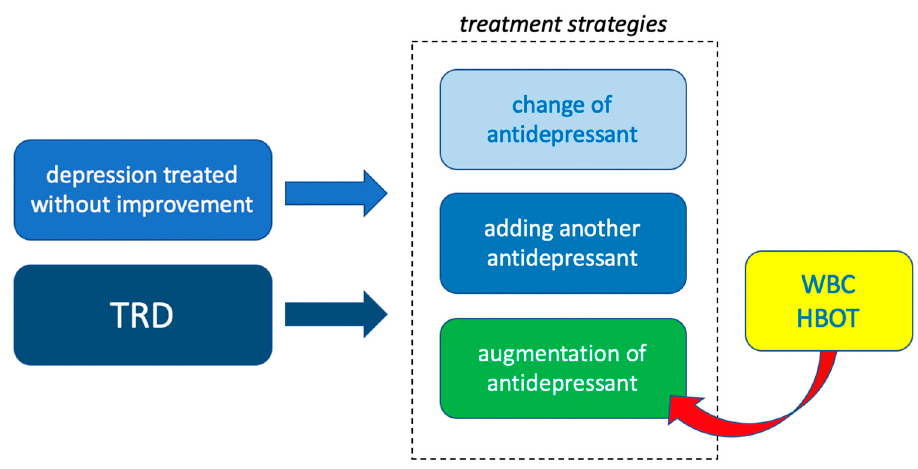
Figure 2. Whole Body Cryotherapy (WBC) and Hyperbaric Treatment (HBOT) could become new methods of antidepressant augmentation, also for treatment resistant depression (TRD). Both methods, WBC and HBOT, have been used in somatic medicine so far, so the protocols for these forms of therapy are well known and confirmed, which means that their introduction to psychiatry may be burdened with a lower risk of the frequency of drop-outs as well as side effects.